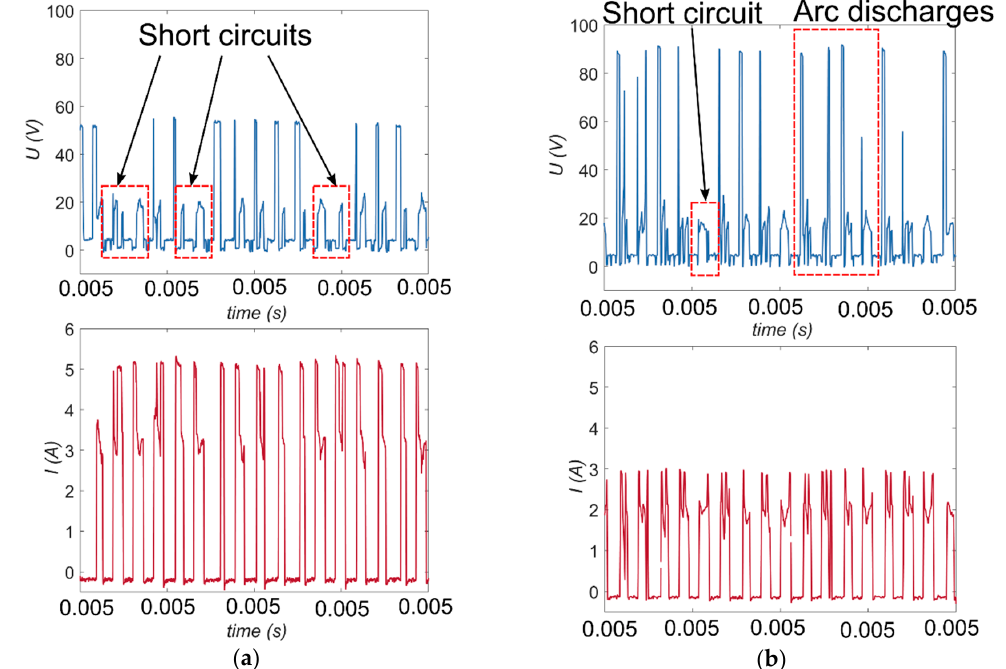
Figure 7. The recorded voltage and current waveforms for the following process parameters: ( a ) U = 60 V, t on = 550 µs, I = 3.33 A, p = 7 MPa, n = 300 rpm; ( b ) U = 100 V, t on = 550 µs, I = 2.00 A, p = 7 MPa, n ( a ) U = 60 V, t on = 550 µ s, I = 3.33 A, p = 7 MPa, n = 300 rpm; ( b ) U = 100 V, t on = 550 µ s, I = 2.00 A, = 300 rpm. p = 7 MPa, n = 300